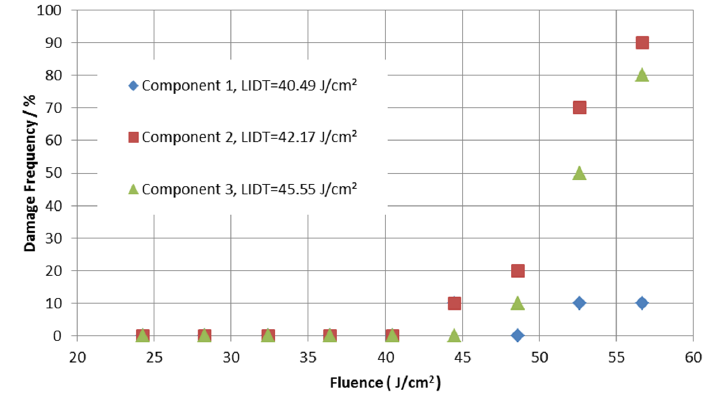
Figure 7. Quantel ‐ tested 200 ‐ on ‐ 1 LIDT of RFS //ZrO 2 /SiO 2 AR coatings on the finished components.